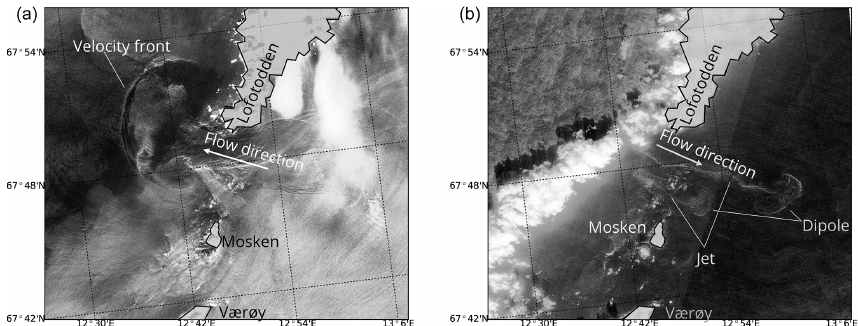
Figure 4. Satellite images from Copernicus Sentinel-2 missions, tracing out surface currents in Moskstraumen and Nordlandsflaget. Panel (a) shows the current structure during westward flow (flood tide); west of Lofotodden, a velocity front is evident which is likely related to dipole formation. Panel (b) shows the current structure during eastward flow (ebb tide); here, a dipole east of the strait with a trailing jet is evident. The Sentinel-2 missions satellites carry a multi-spectral instrument with 13 spectral channels in the shortwave in- frared and visible–near-infrared spectral range, whereas this image is collected from band B4 (664.6nm). The satellite imagery was assessed and processes using data from the Norwegian National Ground Segment for Sentinel data (Halsne et al., 2019, Trygve Halsne, personal communication,